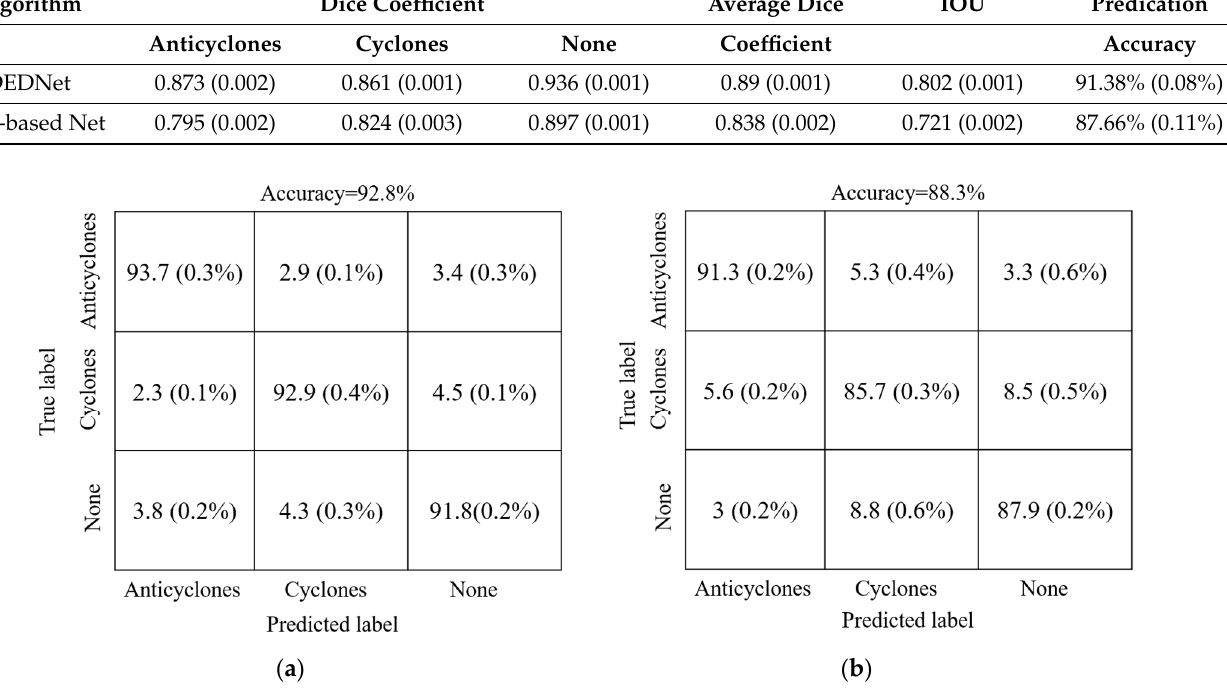
Figure 5. The eddy detection results of three categories. ( a ) DEDNet; ( b ) FCN-based network.